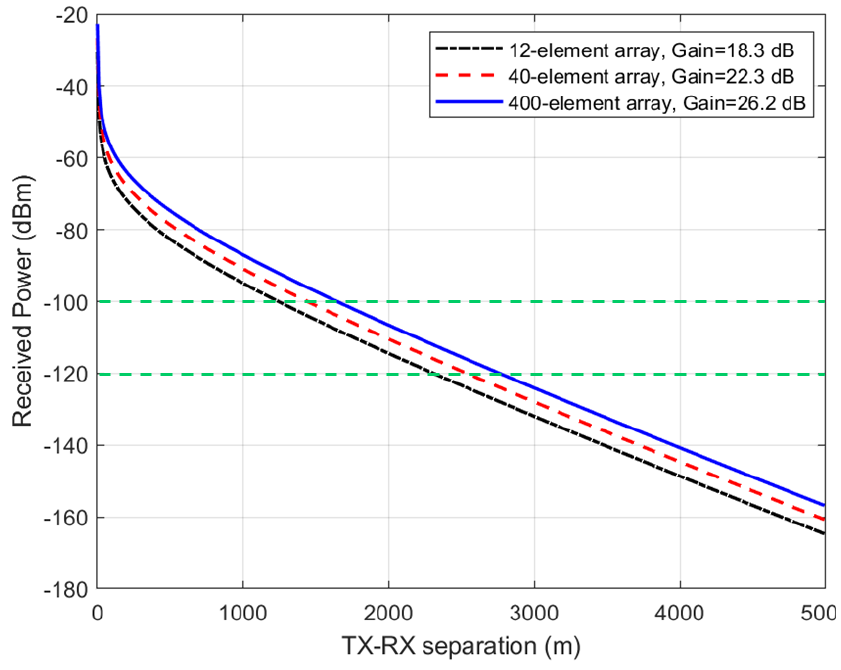
Figure 8. Received power from a UE transmitting 23 dBm (or 200 W) at 60 GHz using the transmitting antenna arrays in Figures 5-7.